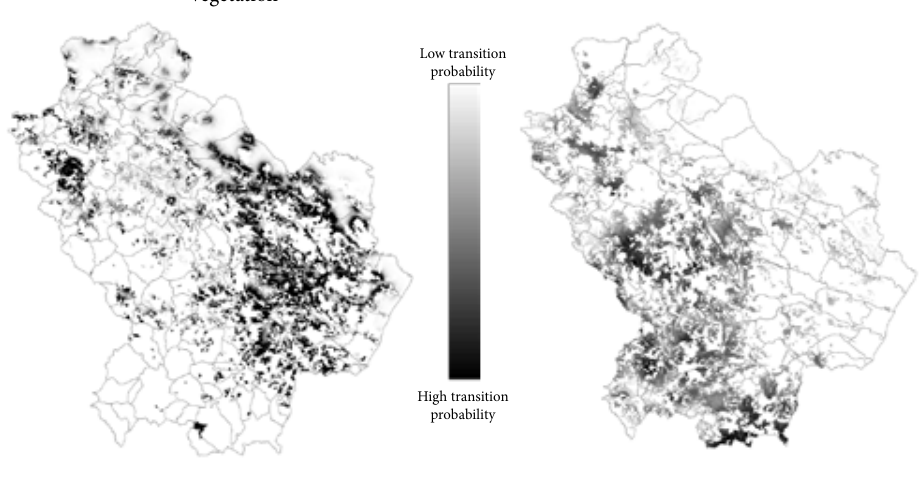
Figure 2. Examples of suitability maps.